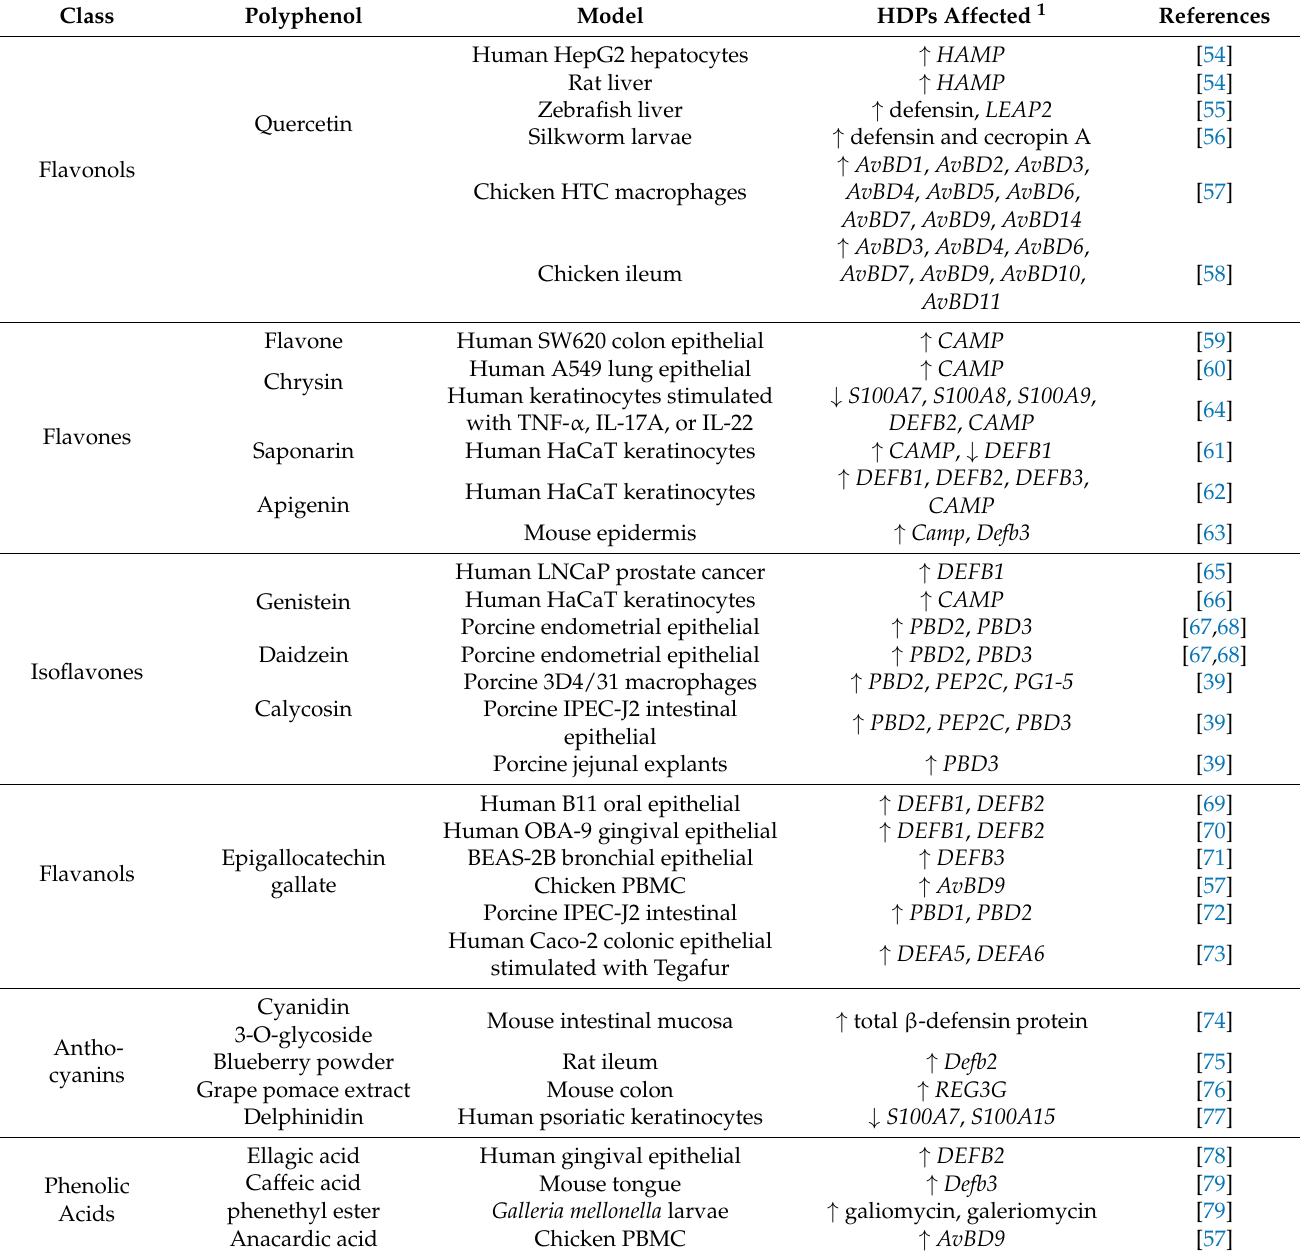
Table 1. In vitro and in vivo regulation of host defense peptide expression by